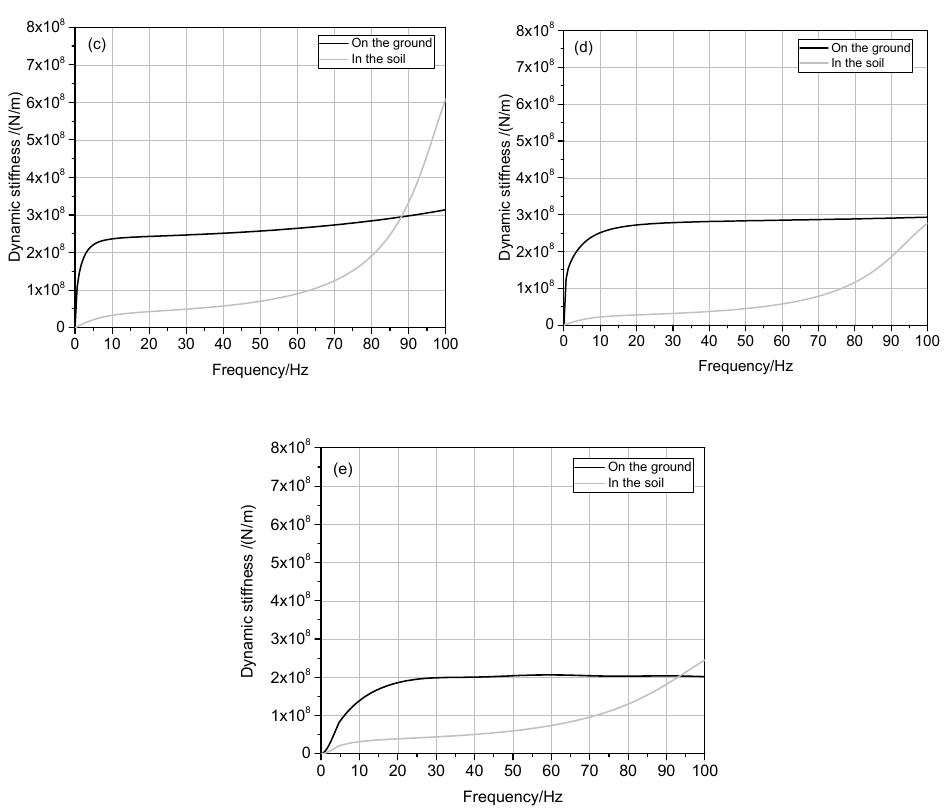
Figure 11. Comparisons of the K d ( f ) values of different foundation models located on the ground and fully buried in the soil: ( a ) model S1; ( b ) model S2; ( c ) model C1; ( d ) model C2; and ( e ) model P3. The above tests are extreme cases when the foundation models are located on the ground.